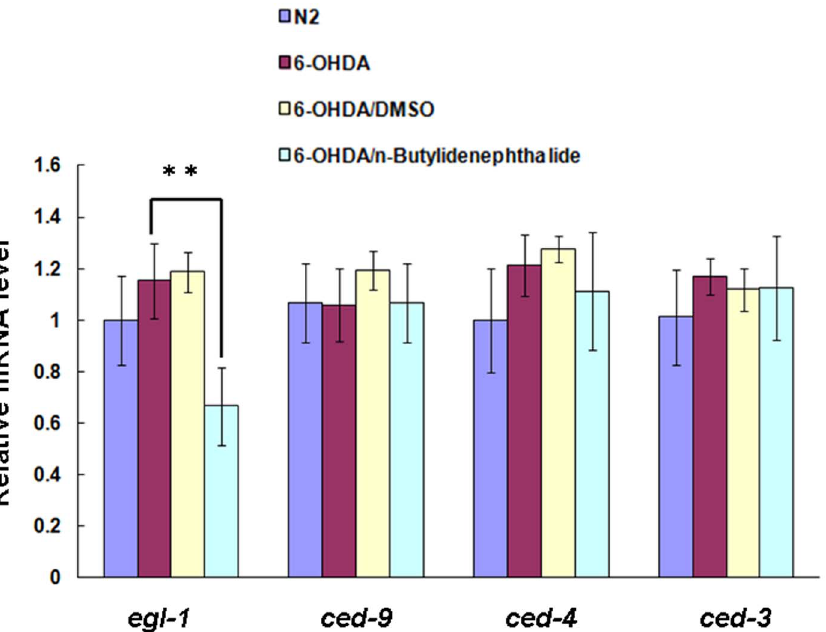
Figure 9. n -Butylidenephthalide lessens egl-1 expression in apoptosis modulation in 6-OHDA-treated C.elegans . Quantitative real-time RT-PCR experiments show the expression levels of egl-1 , ced-3 , ced-4 and ced-9 using RNAs isolated from N2, 6-OHDA-treated, or n - butylidenephthalide/6-OHDA-treated animals. The data represent the mean 6 SD (n=3). An asterisk (*) indicates significant differences between the 6-OHDA-treated control samples and the n -butylidenephthalide/6-OHDA-treated samples (** p , 0.01).